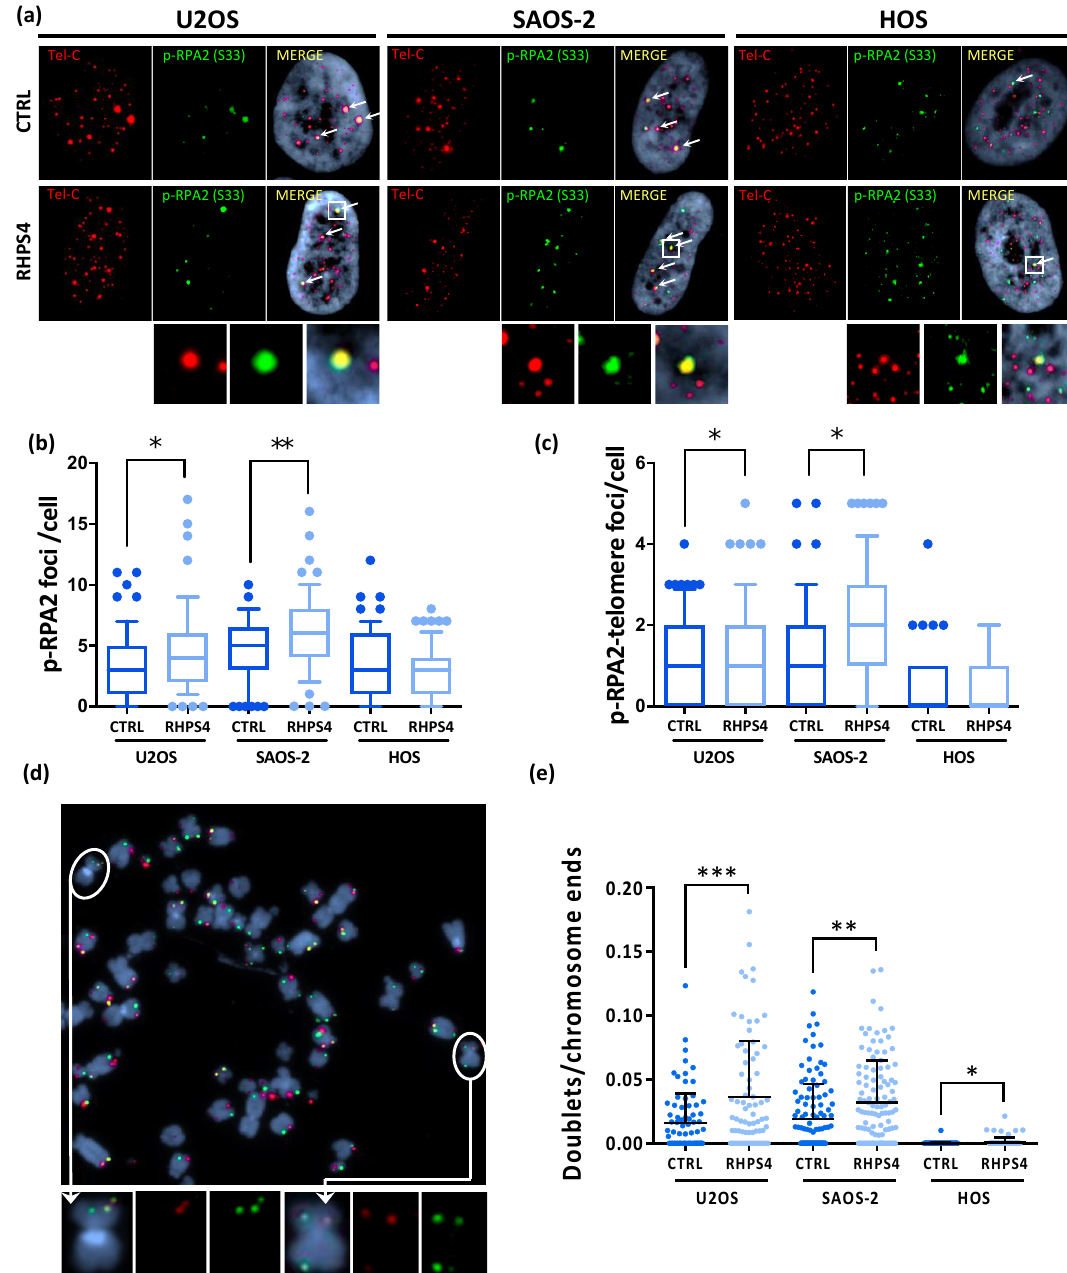
Figure 2. ( a ) Representative images of RHPS4-treated or untreated osteosarcoma cell lines stained for p-RPA2 (S33). For each cell line and condition, single channels (p-RPA2 signals in green and telomeric signals in red) and merged images are illustrated. Arrows indicate p-RPA2 and telomere colocalizations. ( b ) Dotplot showing total amount of p-RPA2 foci per cell. ( c ) Dotplot showing colocalizations between p-RPA2 and telomere. The middle bar denotes median, the box extends from 25th to 75th percentiles and the whiskers above and below the box denote 90th and 10th percentile. ( d ) Representative image of chromosome orientation–FISH (CO–FISH) stained metaphase of SAOS-2 cell line in which double colored doublets are pointed out as shown in enlarged images. ( e ) Dotplot of double color doublets frequency in osteosarcoma cell lines. Black lines denote means and errors bars denote standard deviations. * p < 0.05, ** p < 0.01 , *** p < 0.001.